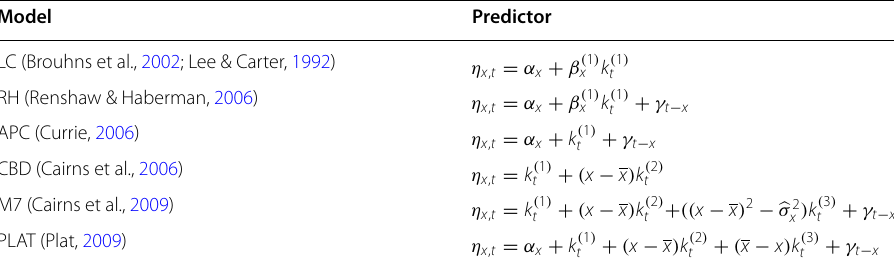
Table 1 GAPC stochastic mortality models Model